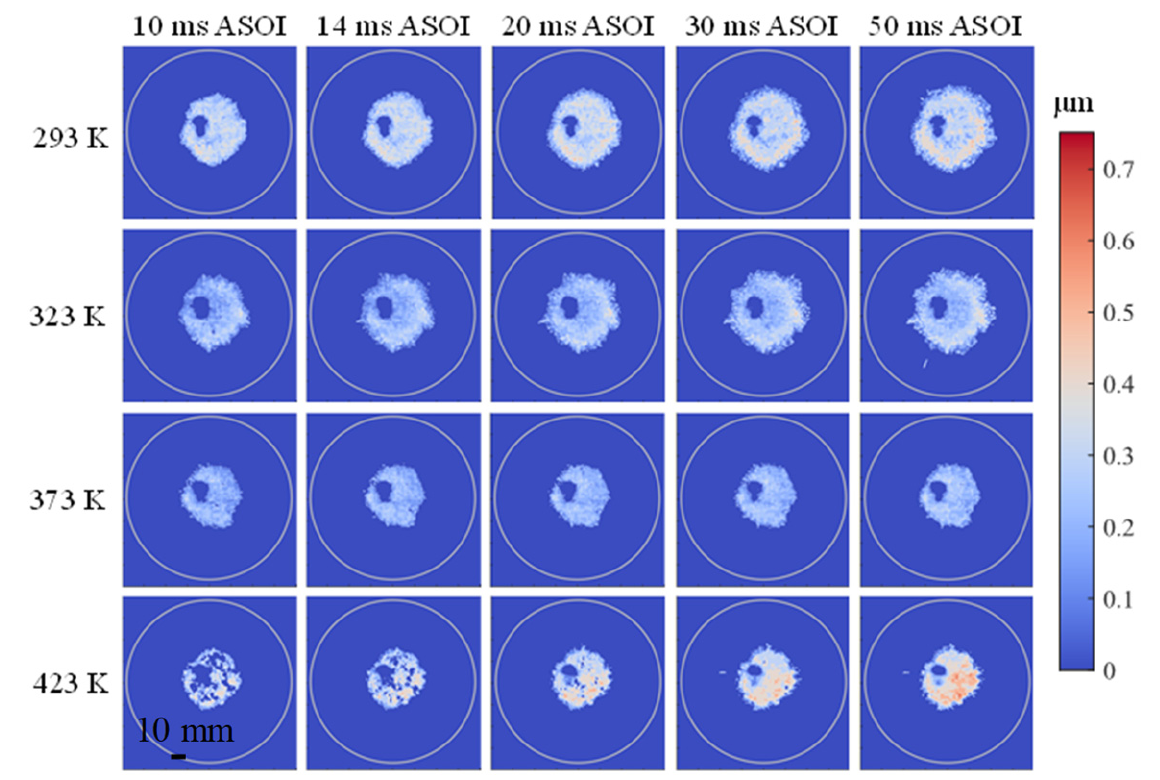
Figure 15. Pseudo color images of fuel film on the wall under different T wall .